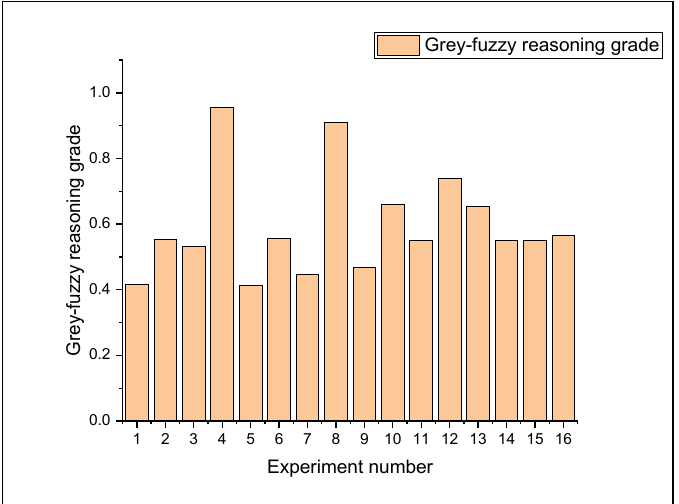
Figure 10. GFRG results for the experimental trails.